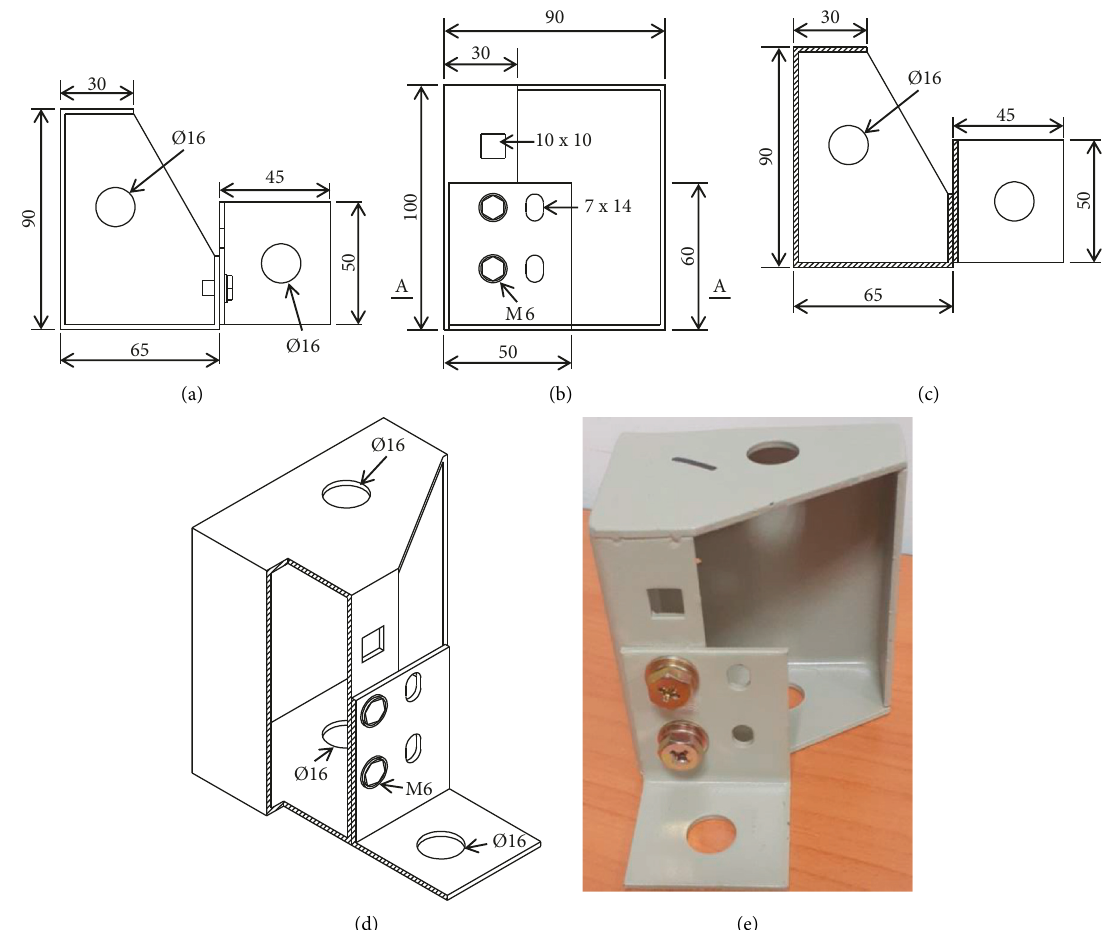
Figure 2: Details of a snip single-corner rectangular pin. (a) Top view. (b) Side view. (c) Section A-A, unit: mm. (d) 3D view. (e) Photo of snip single rectangular